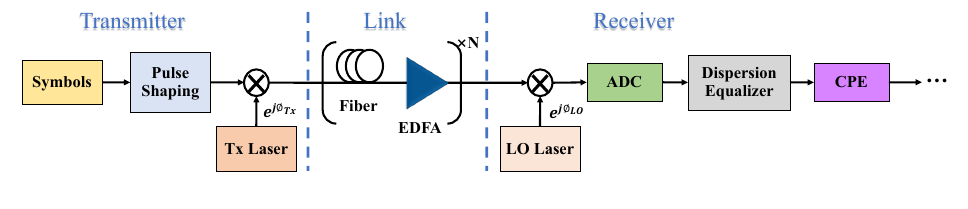
Figure 1. Principle of EEPN in optical fiber